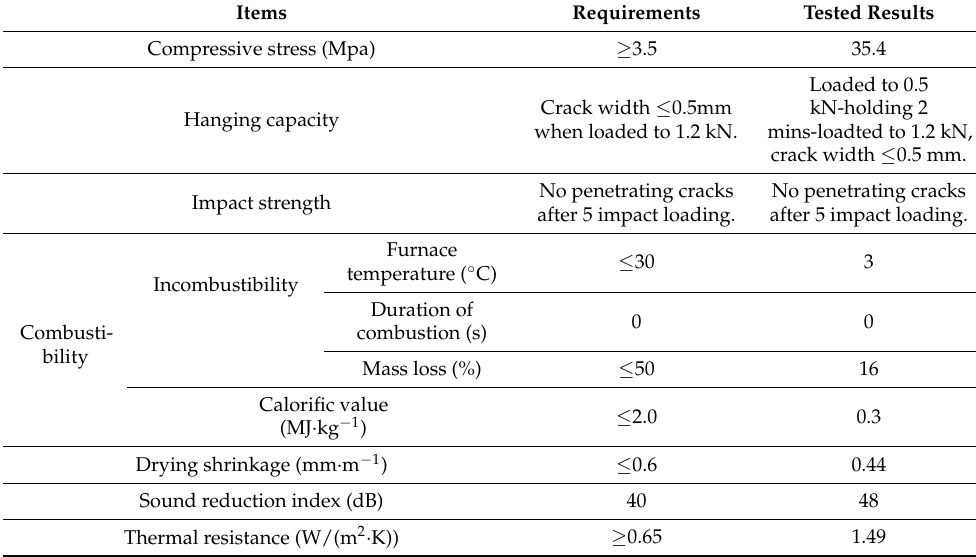
Table 3. Material properties of the EPC